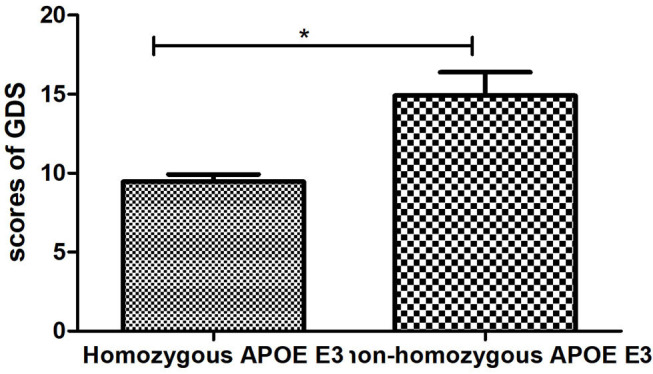
Comparsion of GDS between two groups. *means p < 0.05.